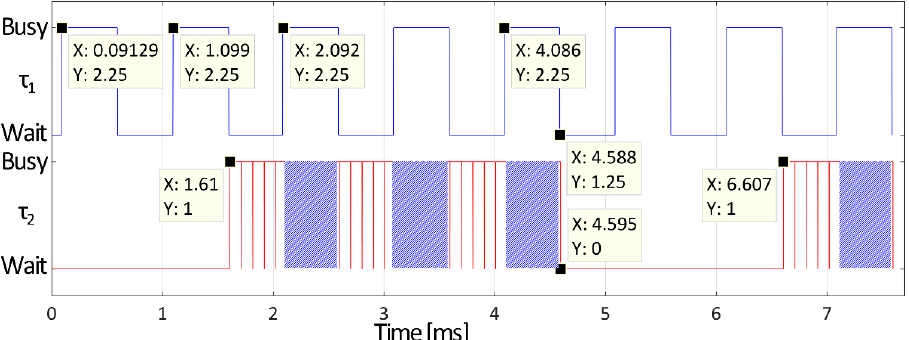
Figure 3. Execution timeline of the real-time tasks for the experiment with two tasks. The blue solid line represents the higher priority task, τ 1 , and the red solid line represents τ 2 .